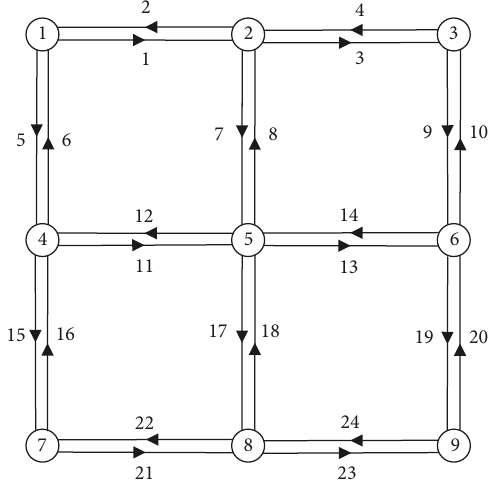
Figure 1: Topology of tested